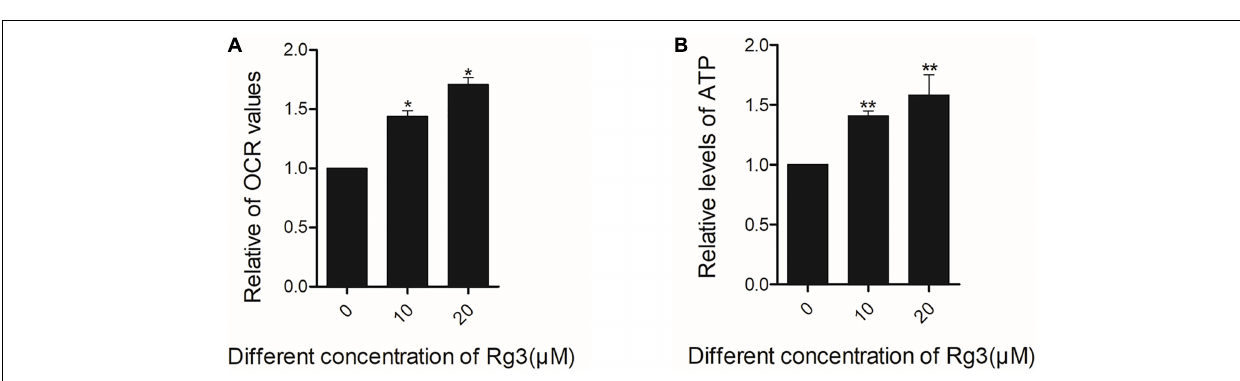
FIGURE 6 | Rg3 increases the basic oxygen consumption and ATP of cells. Cells were treated with Rg3 for 24 h with 10% FBS. (A) The basal oxygen consumption rate (OCR) value were obtained using a Seahorse Extracellular Flux Analyzer. * P < 0.05. (B) the levels of ATP in the treated cells was measured. The data were from three independent experiments and expressed in mean ± SD. The differences between the control and Rg3 treated samples. ** P < 0.